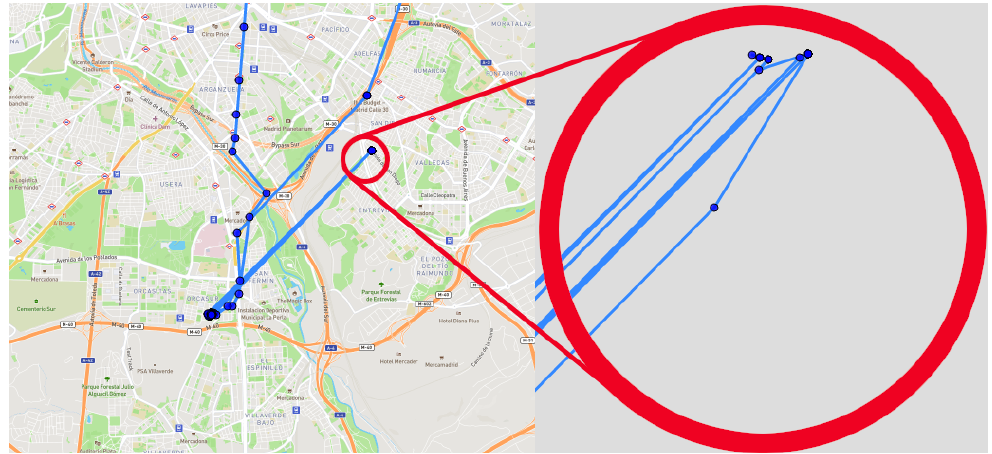
Figure 5. The cluster circled in red on the left is not a real cluster. In the zoom on the right the zig-zag pattern can be